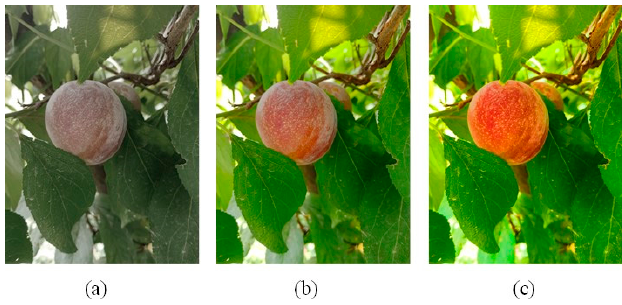
Figure 4. ( a ) Low-saturation, ( b ) medium-saturation, and ( c ) high-saturation images.